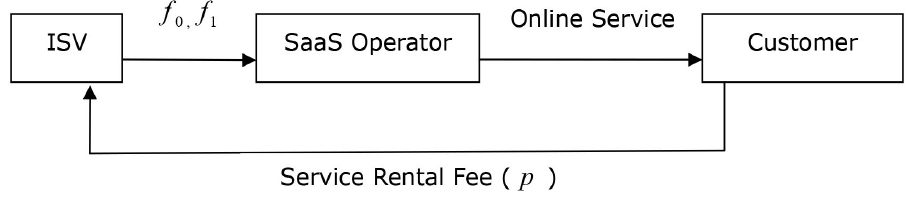
Figure 1. The Basic Model of Compensation